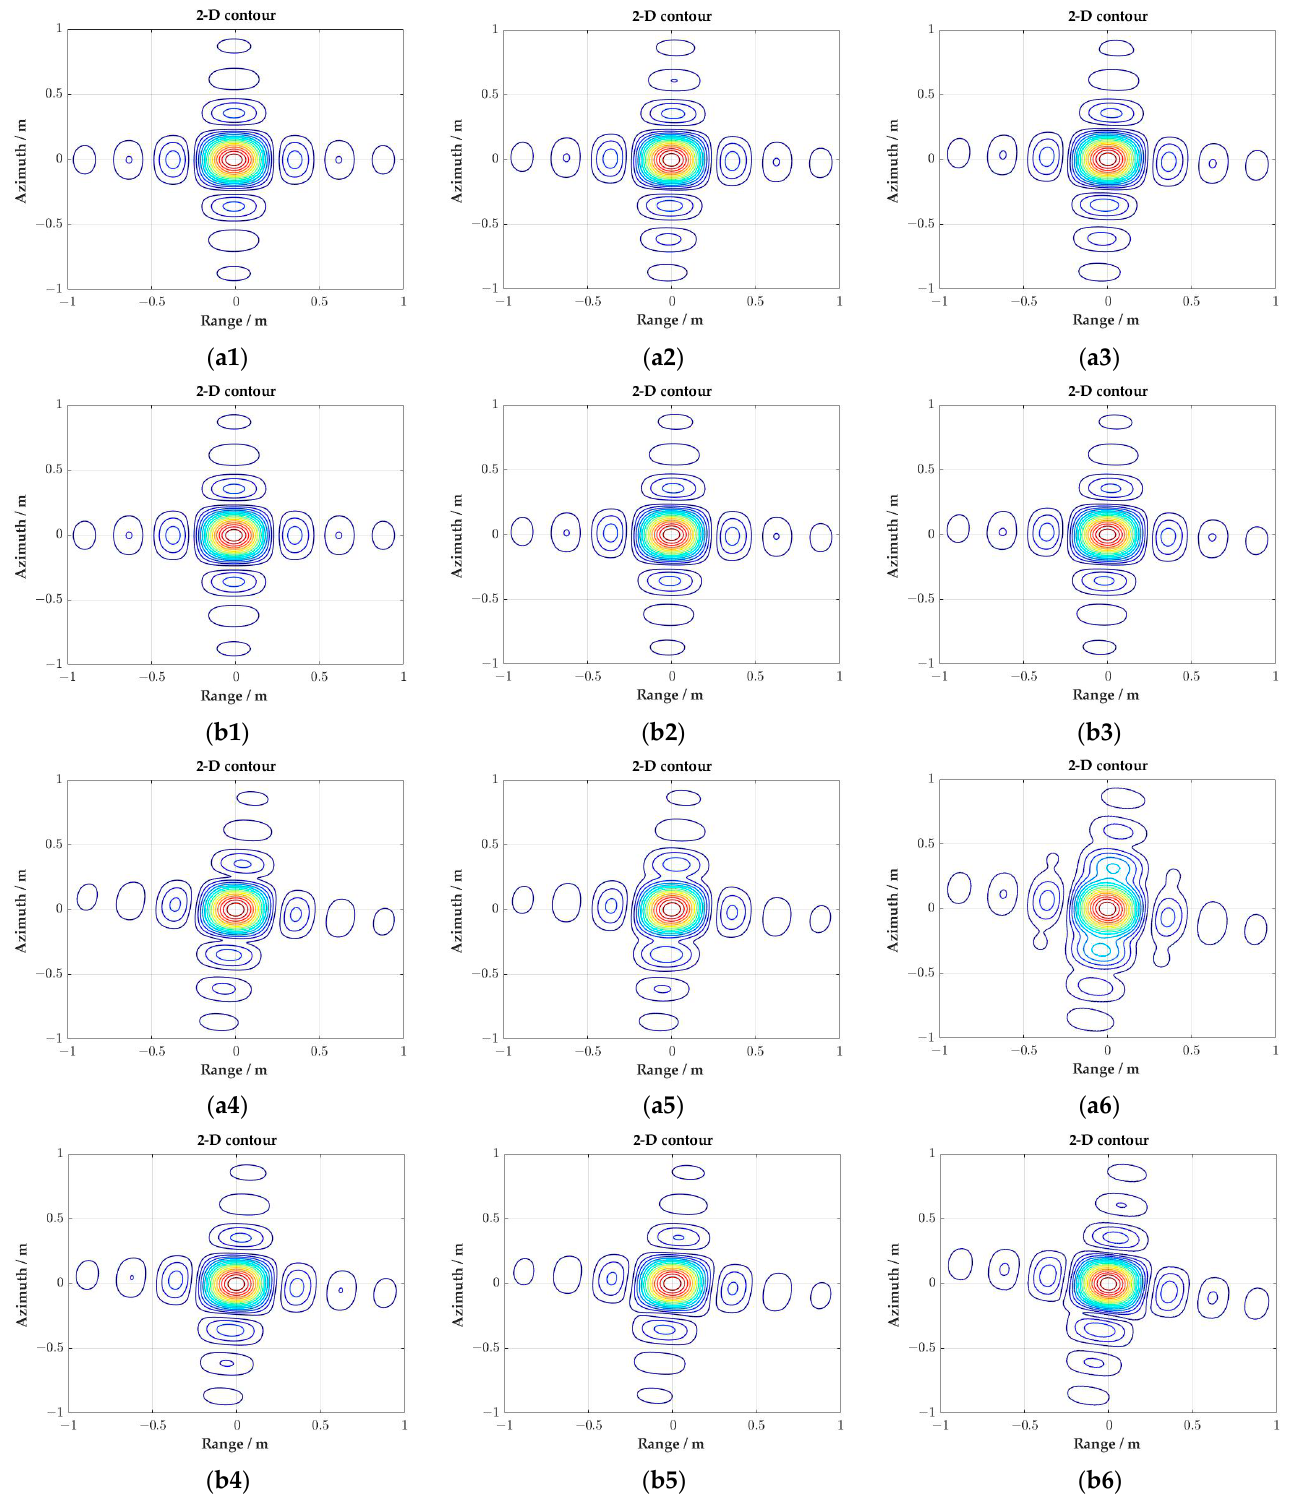
Figure 9. Evaluated results of azimuth profile for the chosen targets corresponding to 0.25 m azi- muth resolution. ( a1 – a6 ) The results of Targets 17–22 before the Doppler phase perturbation. ( b1 – b6 ) The results of Targets 17–22 after the Doppler phase perturbation. All of the results have been up-sampled by 32× to better illustrate the details.